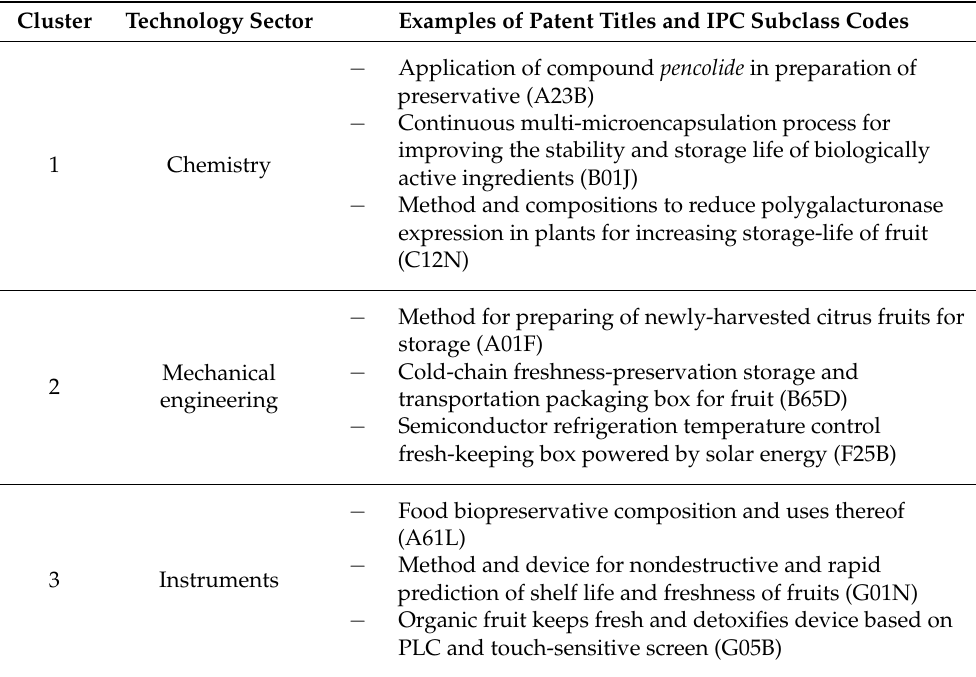
Table A2. Examples of patent titles from the technology